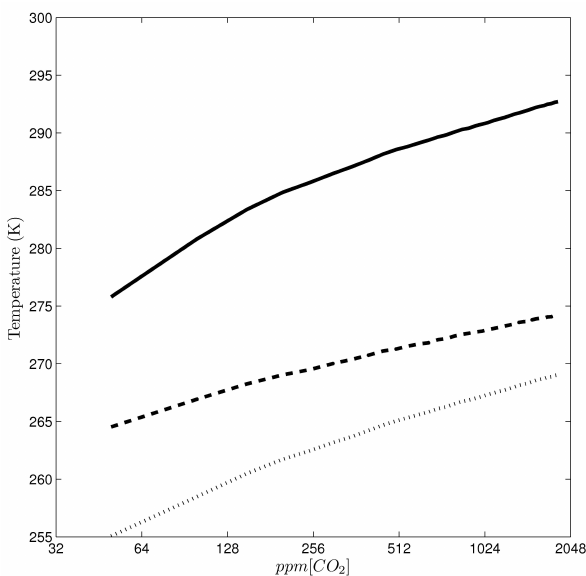
Fig. 1. Time average of the global mean surface temperature T s (solid line) and of the temperature of the warm ( 2 + ) and cold ( 2 − ) reservoirs (dashed and dotted lines, respectively).